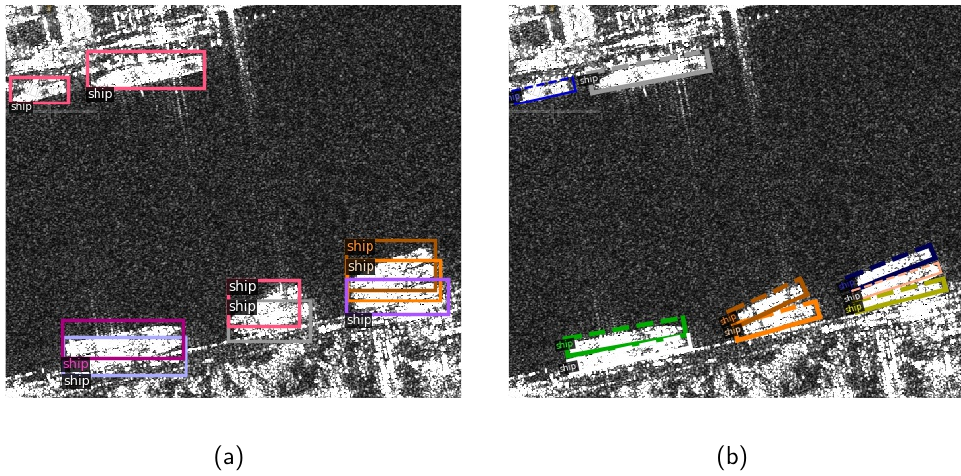
Figure 1. Densely arranged ships in an inshore complex background. ( a ) marking ship regions with horizontal bounding boxes; ( b ) marking ship regions with rotated bounding boxes.